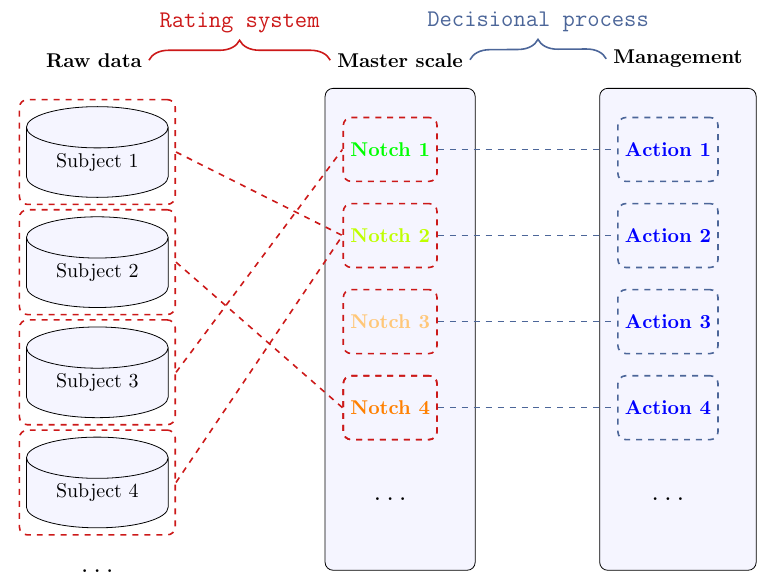
Figure 1. Schematics of the rating and decisional